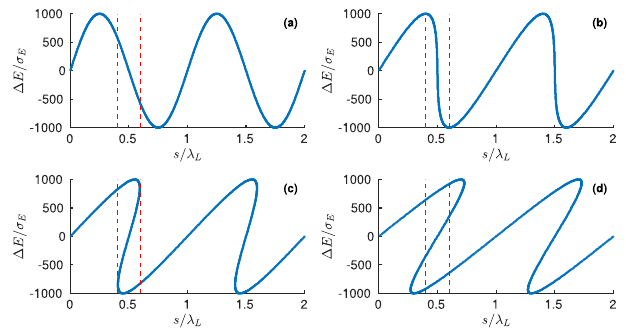
FIG. 1. A schematic illustration of the short pulse train generation scheme. A long-wavelength laser λ electron beam in the first undulator (U1). This beam may then be optionally precompressed by a small four-dipole magnetic chicane (C1), before radiating in another undulator (U2) tuned to a high harmonic of the seed laser. The result is a train of few- cycle radiation pulses at the up-converted wavelength λ modulation will be converted into a density modulation, and eventually the beam will overdisperse, as shown in Fig. 2. In this comoving frame, an electron with relative energy deviation δγ = γ will move longitudinally with respect to the reference electron at a rate,